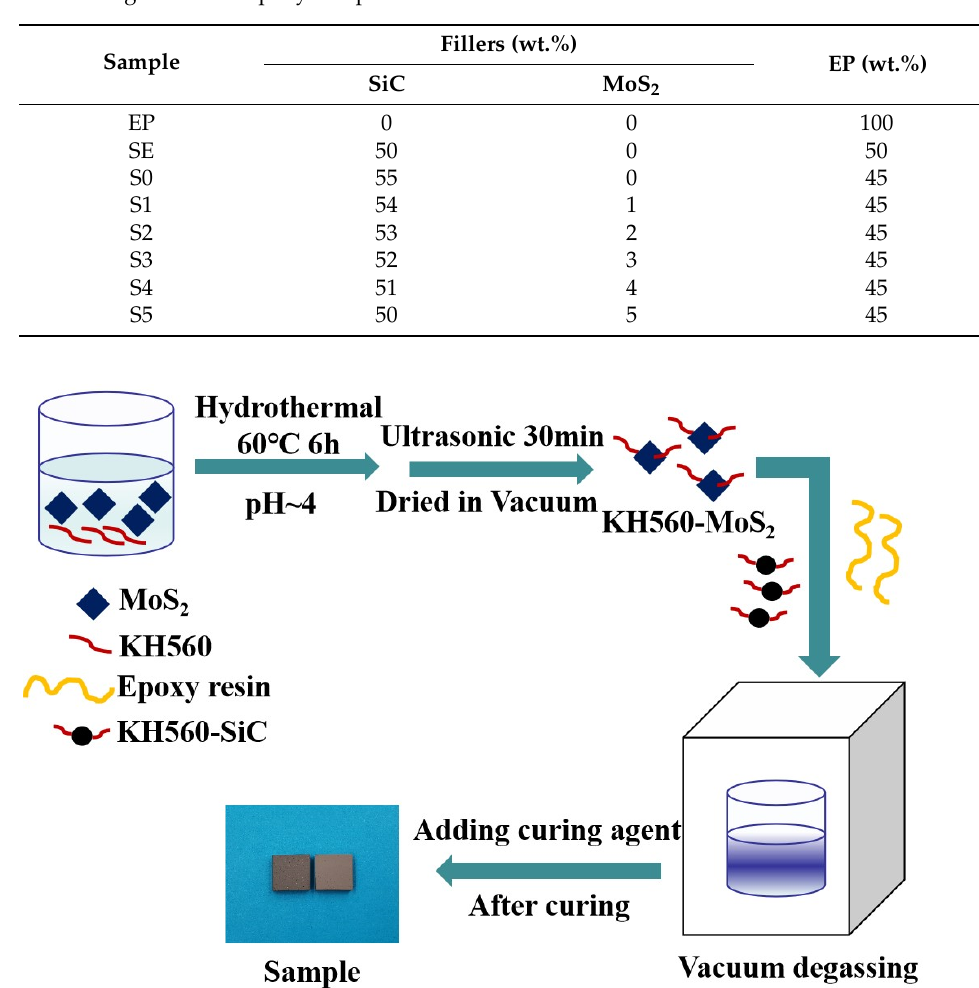
Figure 1. Diagrammatic representation of modified MoS 2 /SiC/EP composites’ preparation.